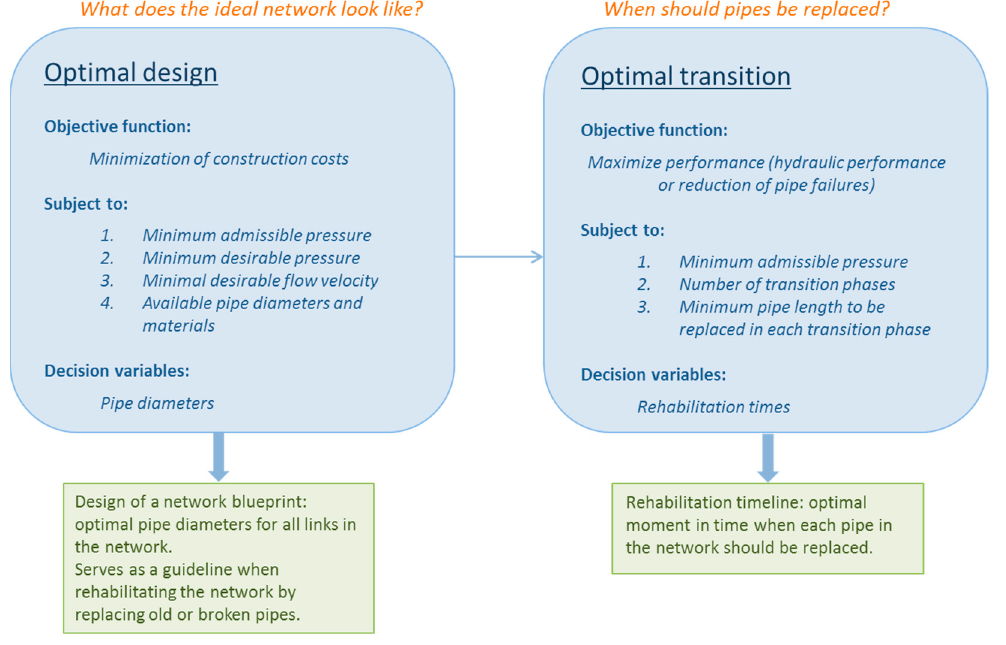
Figure 1. Schematic representation of the proposed approach for the design of and transition to network